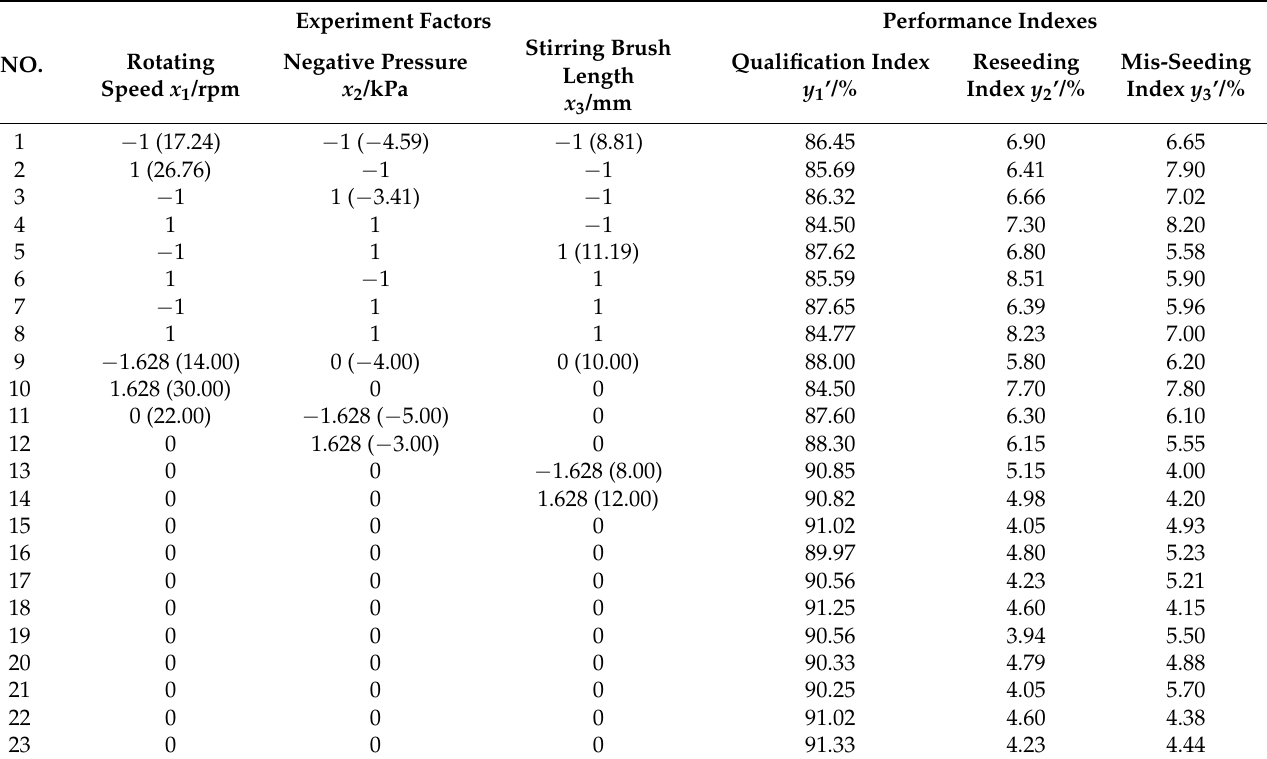
Table 4. Test protocol and results.